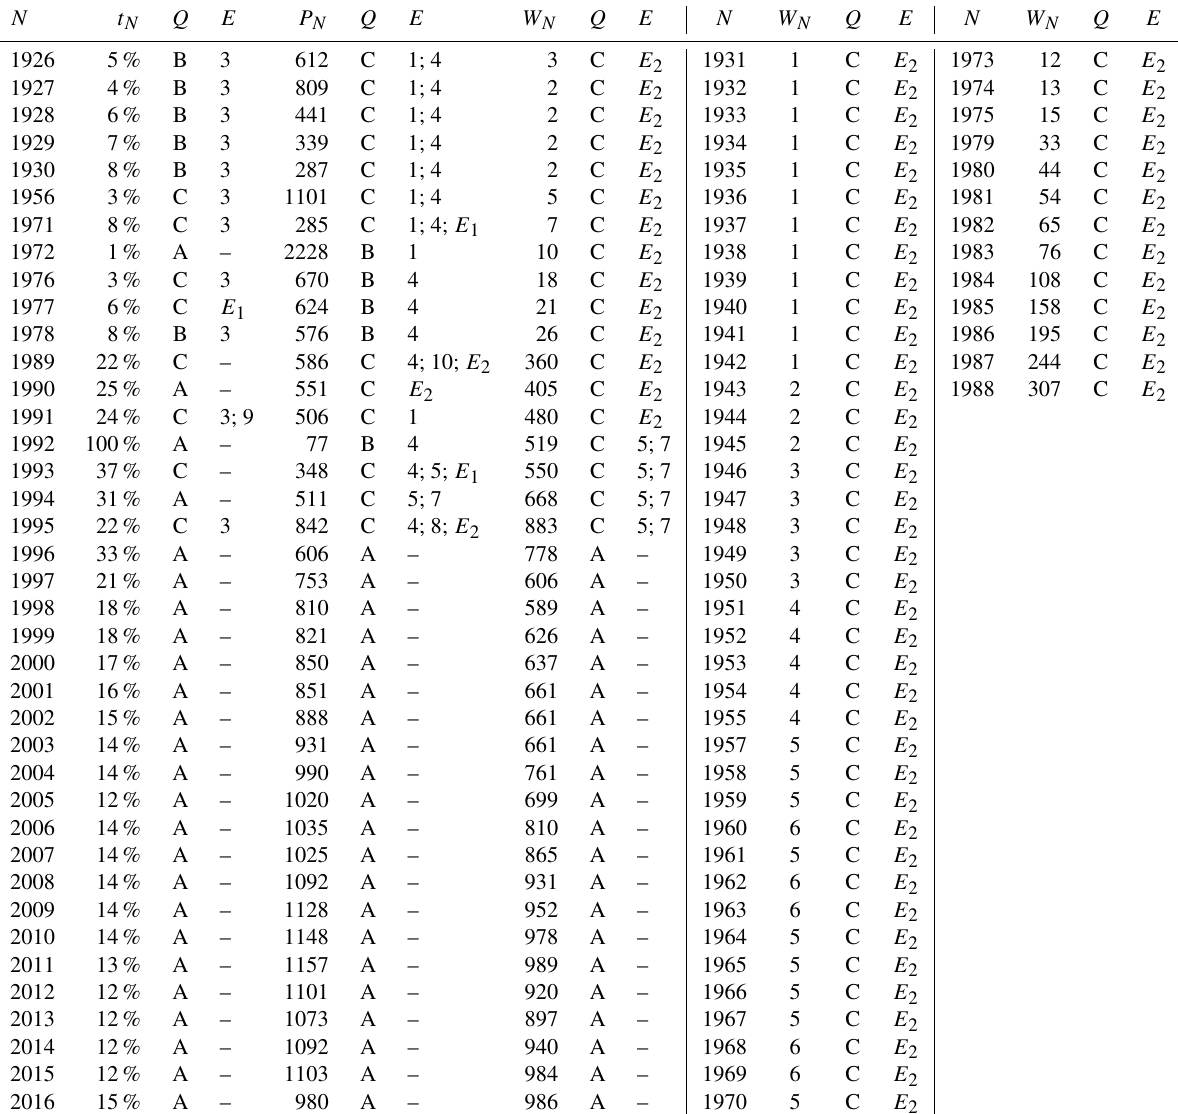
Table 2. The California homeowners earthquake insurance database developed for this study. Data quality scale is as follows. A (good): all data from scientific publications with methodology explained; (B) acceptable: at least one data point from a scientific publication without details on the methodology or one processing has been applied; (C) weak: data are uncertain. Financial amounts are in 2015 US dollars. The total written premium is given in millions of US dollars. Column names are Q : data quality; E : equation ID. Abbreviations are E 1 = { 3;